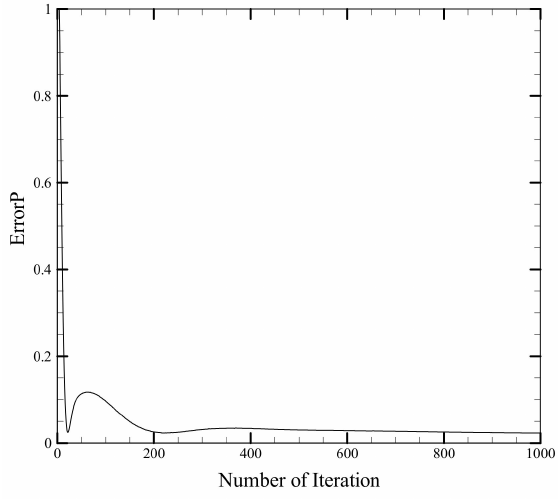
Figure 11. Variations of the residual of pressure differences through the iteration steps in the validation of UESA.